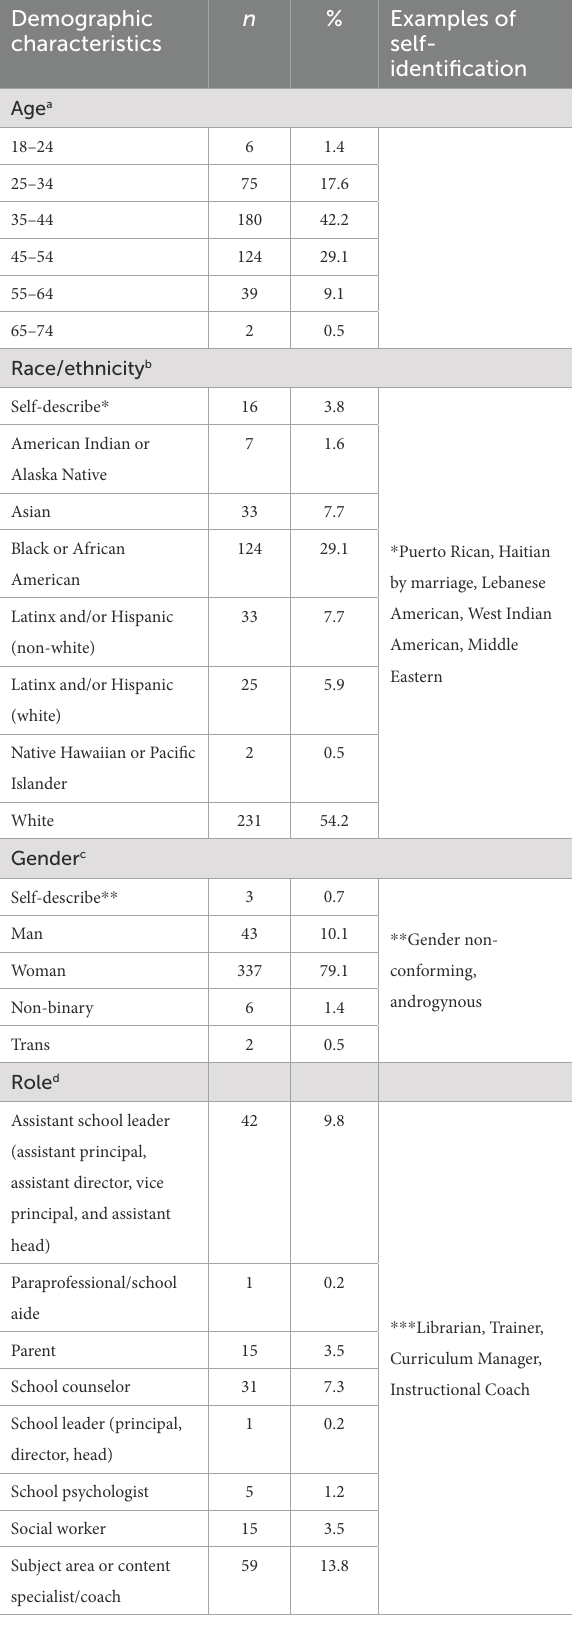
TABLE 1 Sociodemographic characteristics of participants ( N =